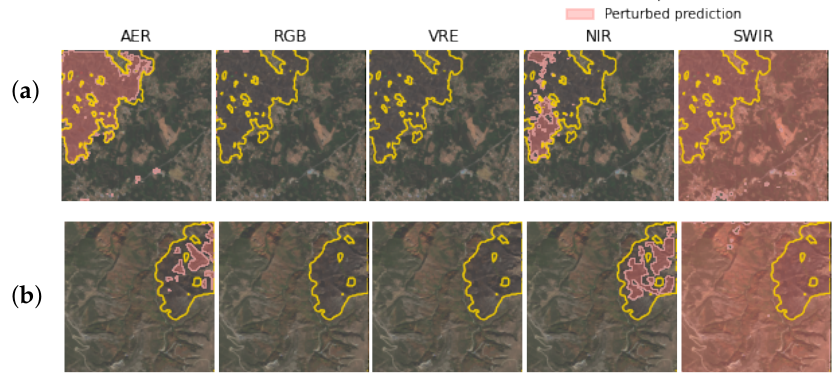
Figure 8. Visualization of the all_occlusion results for the different Multi-bands. Rows ( a ) and ( b ) are two satellite examples from coral and cyan fold,